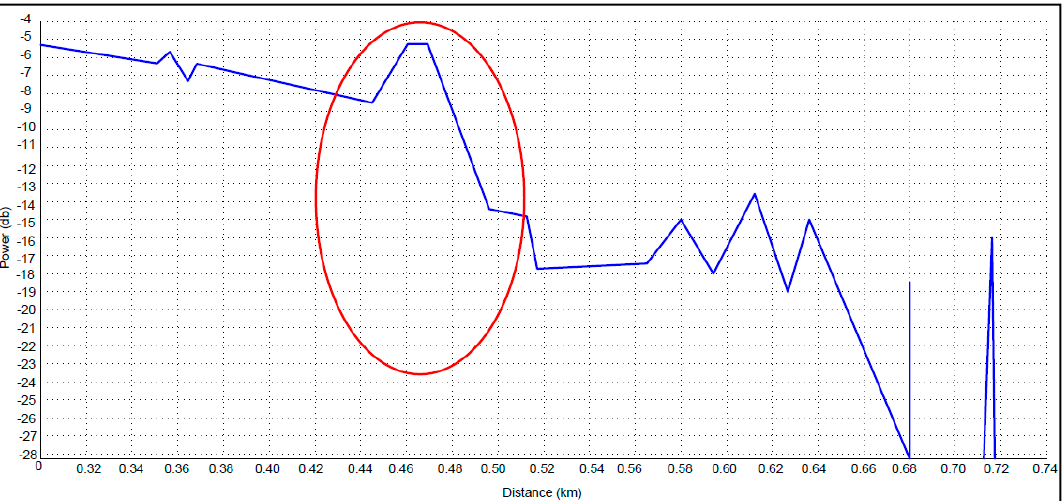
Figure 9. The improving FPMT circuit detected a fiber end-face burning pattern shape in event 3. Table 7. The parameters and practical results detected at event 3.